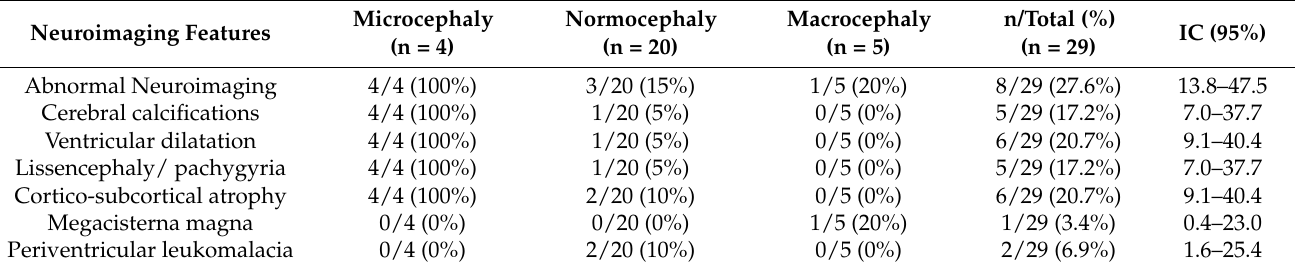
Table 5. Neuroimaging findings according to the classification of head circumference at birth of 29 children exposed to Zika virus in the intrauterine period, Manaus,